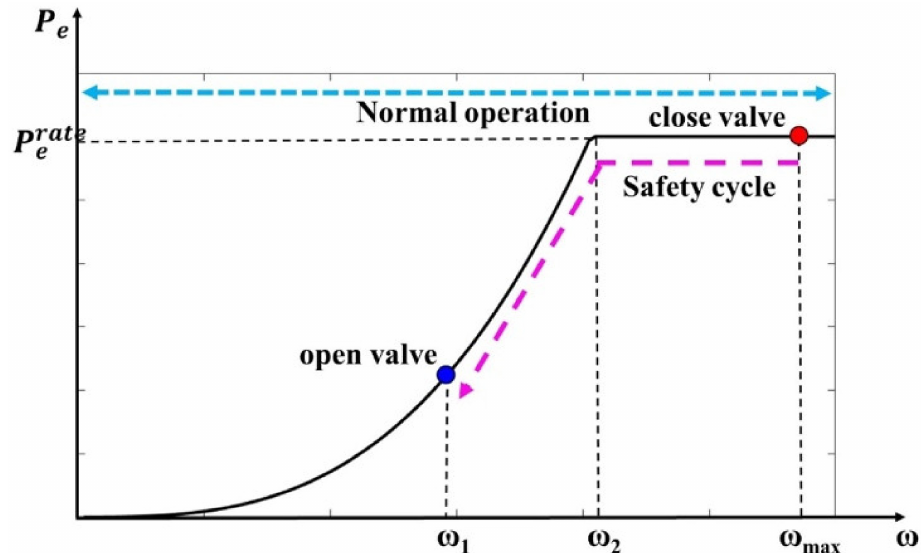
Figure 1. Conventional control method for